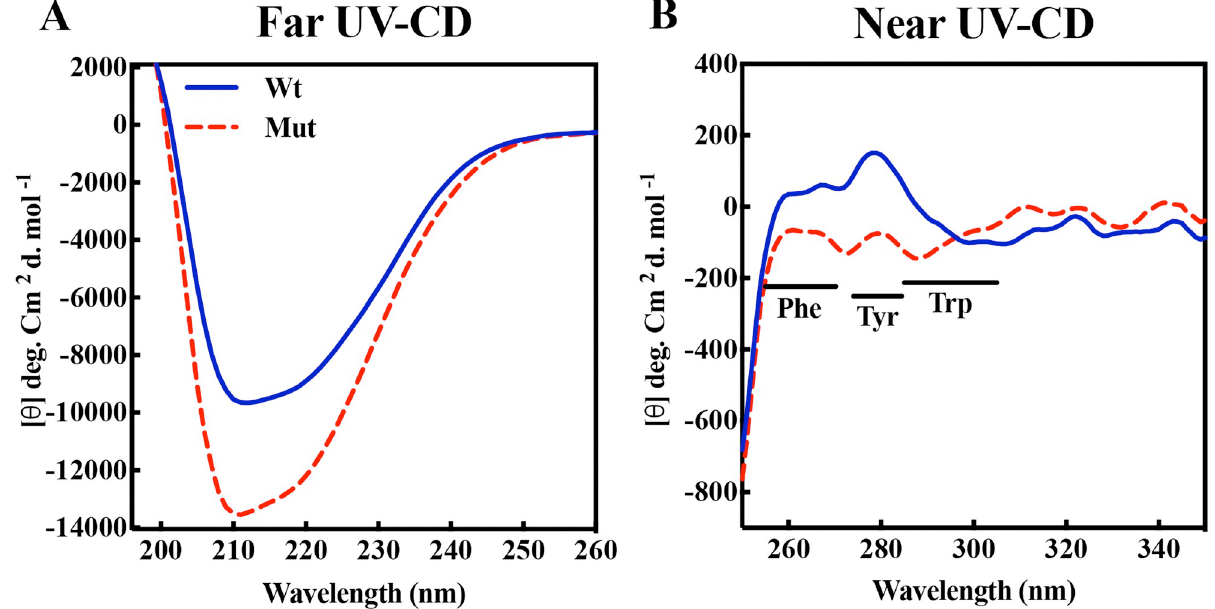
Fig 2. The secondary and tertiary structure studies of different α B-crystallins using UV-CD spectroscopy. A ) Far UV-CD and B ) Near UV-CD spectra of wild-type and mutant α B-crystallins were done in buffer A at 25 ˚C.